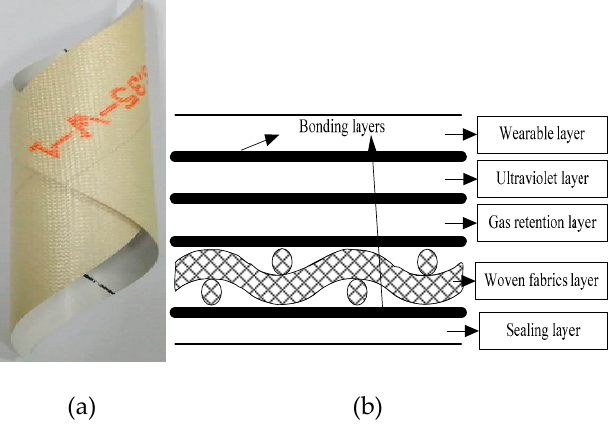
Figure 1. Envelope material [18], ( a ) macro morphology; ( b ) Typical envelope material. Table 1. Mechanical parameters of envelope Uretek-3216LV [29].